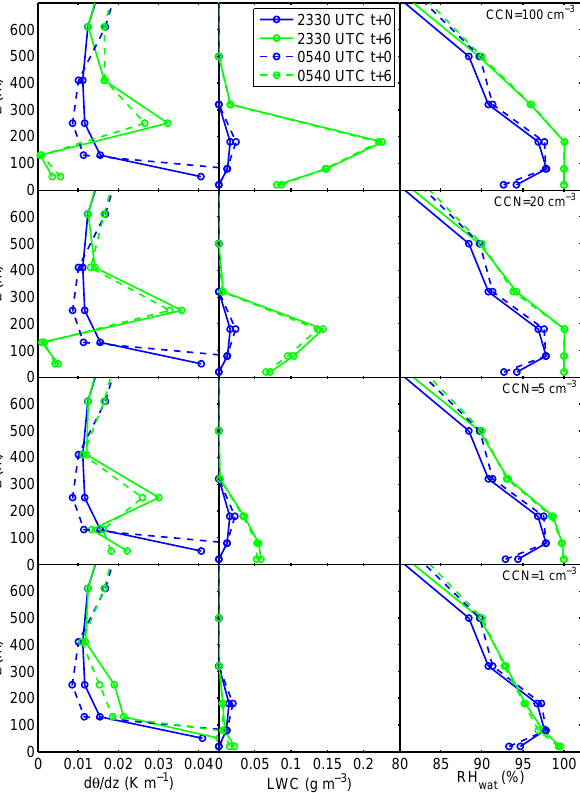
Fig. 9. Static stability, cloud liquid water concentration and relative humidity from the SCM. The model was initialised at 23:30UTC, DoY 244 (solid lines) and 05:40UTC, DoY 245 (dashed lines), us- ing radiosonde profiles. The upper panel shows results from the control run, where CCN = 100cm − 3 and the lower panels shows results from experiments, where CCN = 20, 5 and 1cm − 3 . The blue and green colours represent the SCM diagnostics at t + 0 and t + 6h